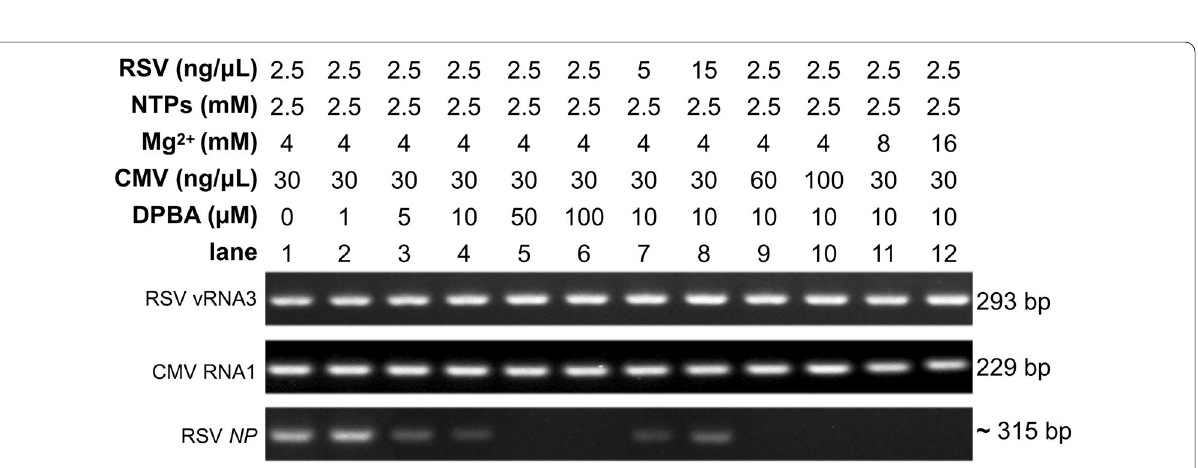
Fig. 3 The effect of DPBA on the transcription of RSV. The chimeric RSV mRNA (RSV NP ) produced in vitro from each reaction with a mixture as indicated on top of the gel was amplified by RT-PCR. Similar nested RT-PCR was conducted to detect RSV and CMV genomic RNAs. The RT-PCR product was electrophoresed in a 1.5% agarose gel before being